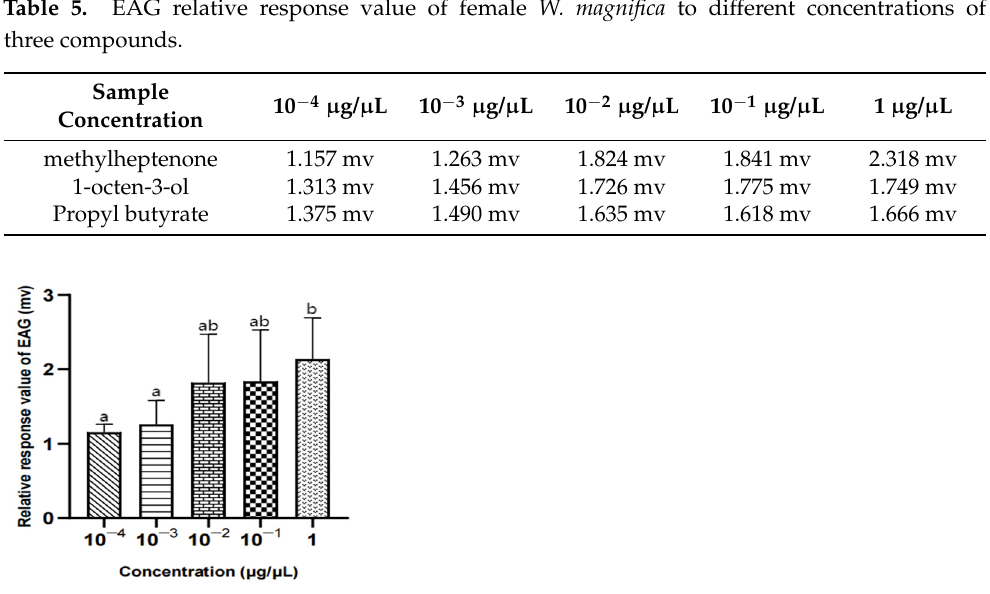
Figure 21. EAG responses of female W. magnifica to different concentrations of methylheptenone.